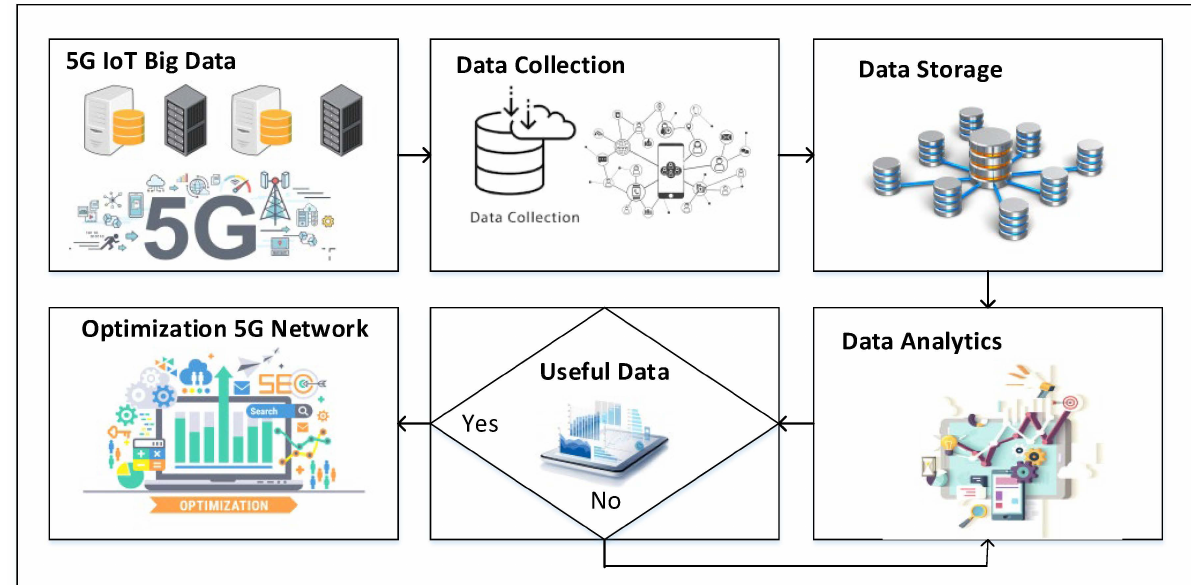
Figure 1. Proposed data analytics